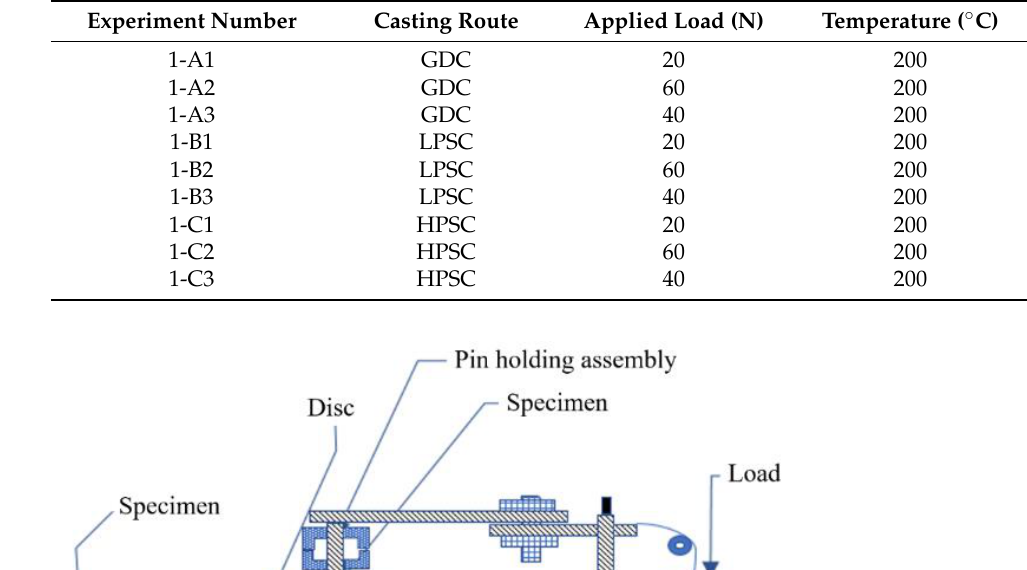
Table 2. Al-Si alloys wear test input parameters.